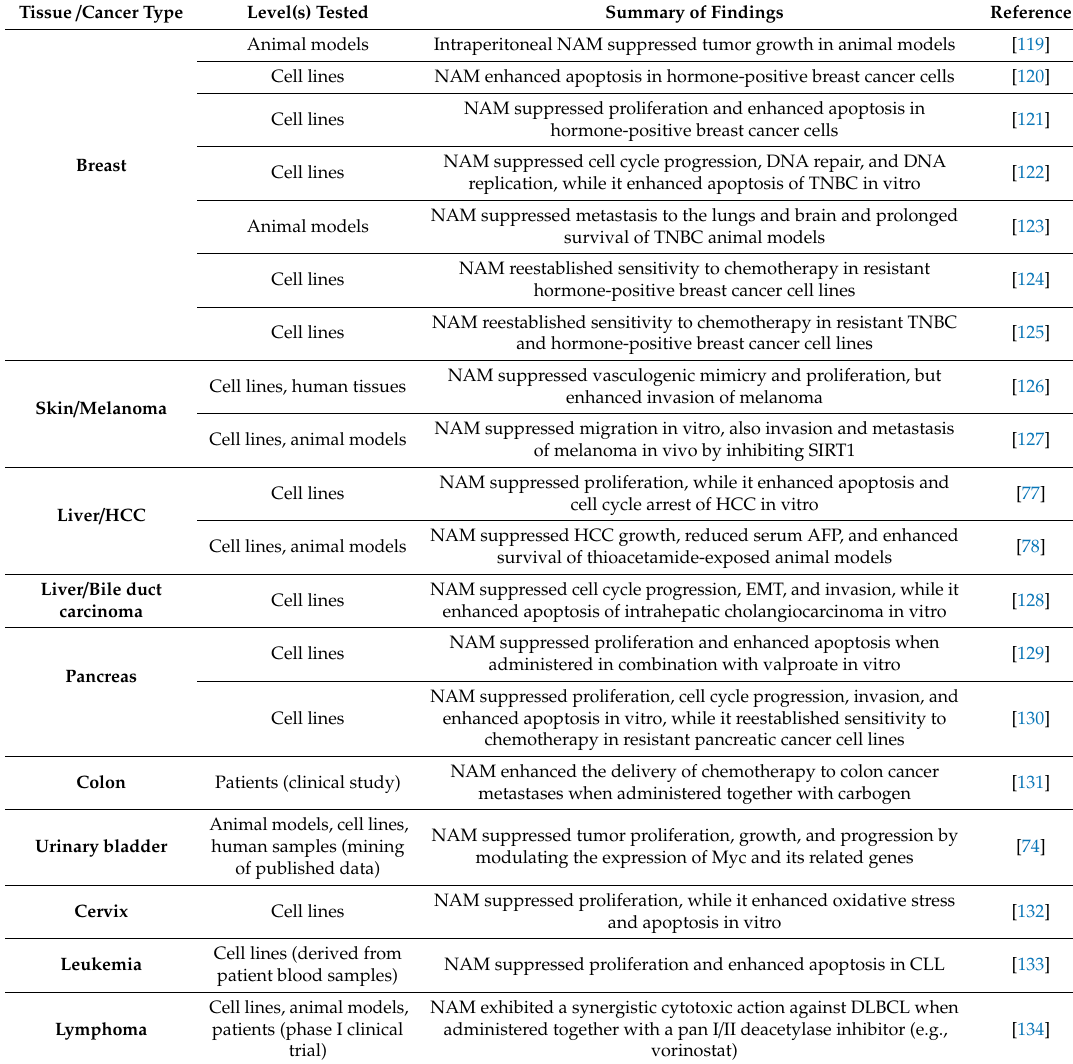
Table 3. Summary of evidence (preclinical, clinical) that supports the role of nicotinamide (NAM) in cancer